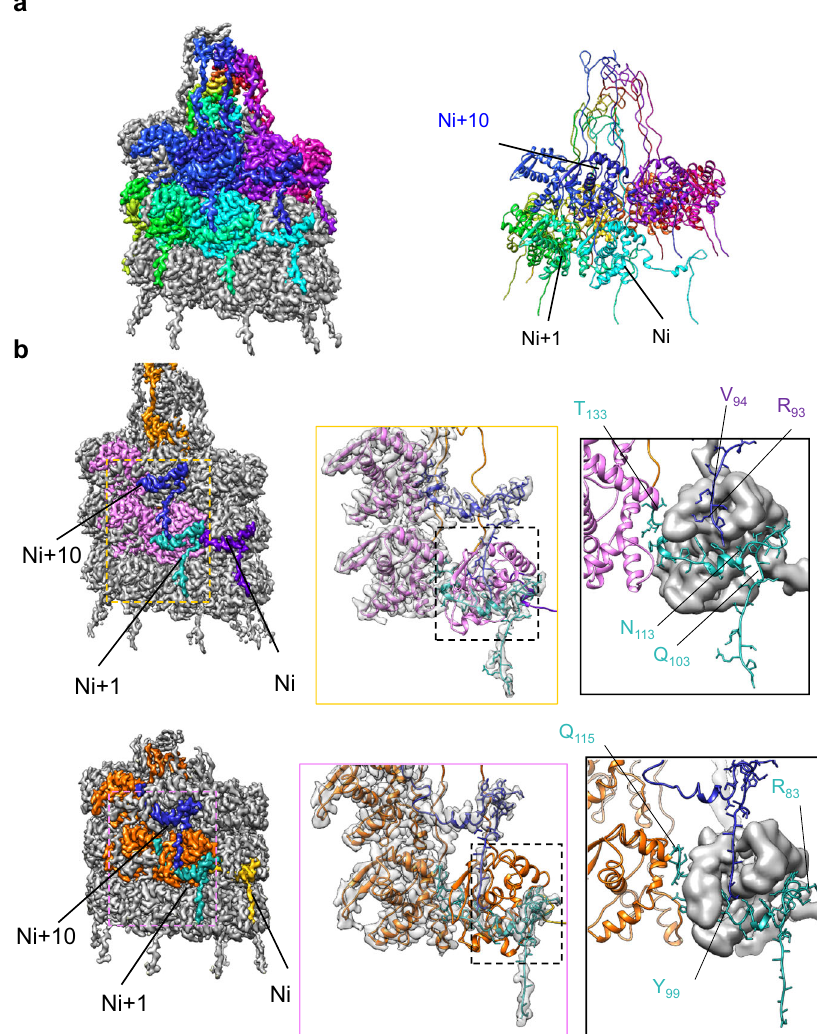
Fig. 5 Subunit arrangement in the sweet potato VLPs. a CryoEM map of SPFMV coloured according to the subunit elevation along a helical turn (starting subunit in cyan and 10th subunit in dark blue). Right panel shows the corresponding structural model of one complete segment with fi rst, second and 10th subunits labelled. b CryoEM map of SPFMV (top panel) coloured according to N-termini of fi rst CP (in purple), N + 1 (in cyan) and N + 10 CP (in dark blue) along the helical segment. The three CPs are coloured in pink with the C-terminus in orange. Bottom panel shows cryoEM map of SPMMV, coloured according to N-termini of fi rst CP (in gold), N + 1 (in cyan) and N + 10 (in dark blue). Middle panels show a close-up view of the N-terminus organization between Nth, N + 1 and N + 10 CP in both SPFMV and SPMMV structures. Right panels show the outlined, zoomed-in area for N-terminal interaction with Nth CP via N + 1 (cyan) and N + 10 (dark blue) N-terminus in SPFMV (top right) and SPMMV (bottom right) respectively. Key residues are labelled with the Nth CP shown as gaussian fi ltered map to illustrate binding pockets, N + 1 model in pink (SPFMV) and in orange (SPMMV), with their N-terminal segments in cyan and the N + 10 N-terminal segments shown in dark